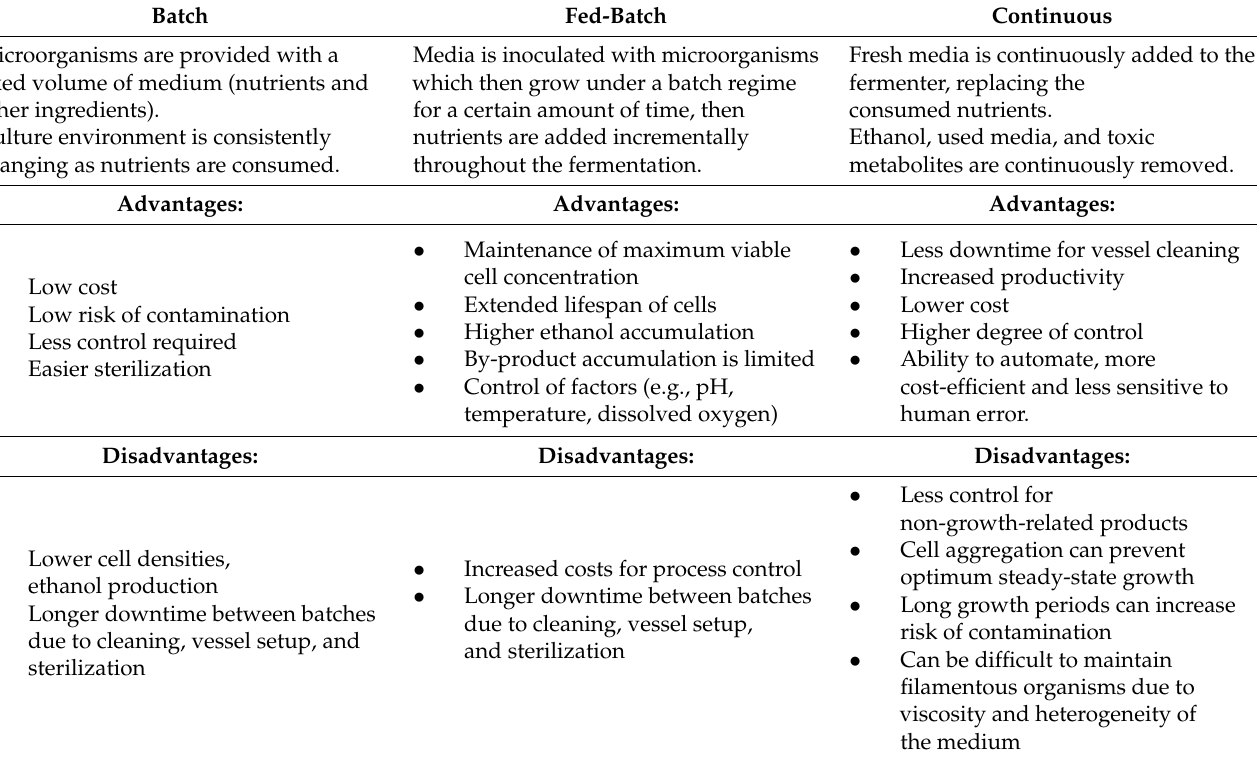
Table 4. Comparison between batch, fed-batch, and continuous fermentation under a submerged/liquid state [74,79]. Batch Fed-Batch Continuous Microorganisms are provided with a Media is inoculated with microorganisms fixed volume of medium (nutrients and which then grow under a batch regime other ingredients). for a certain amount of time, then Culture environment is consistently nutrients are added incrementally changing as nutrients are consumed. throughout the fermentation.